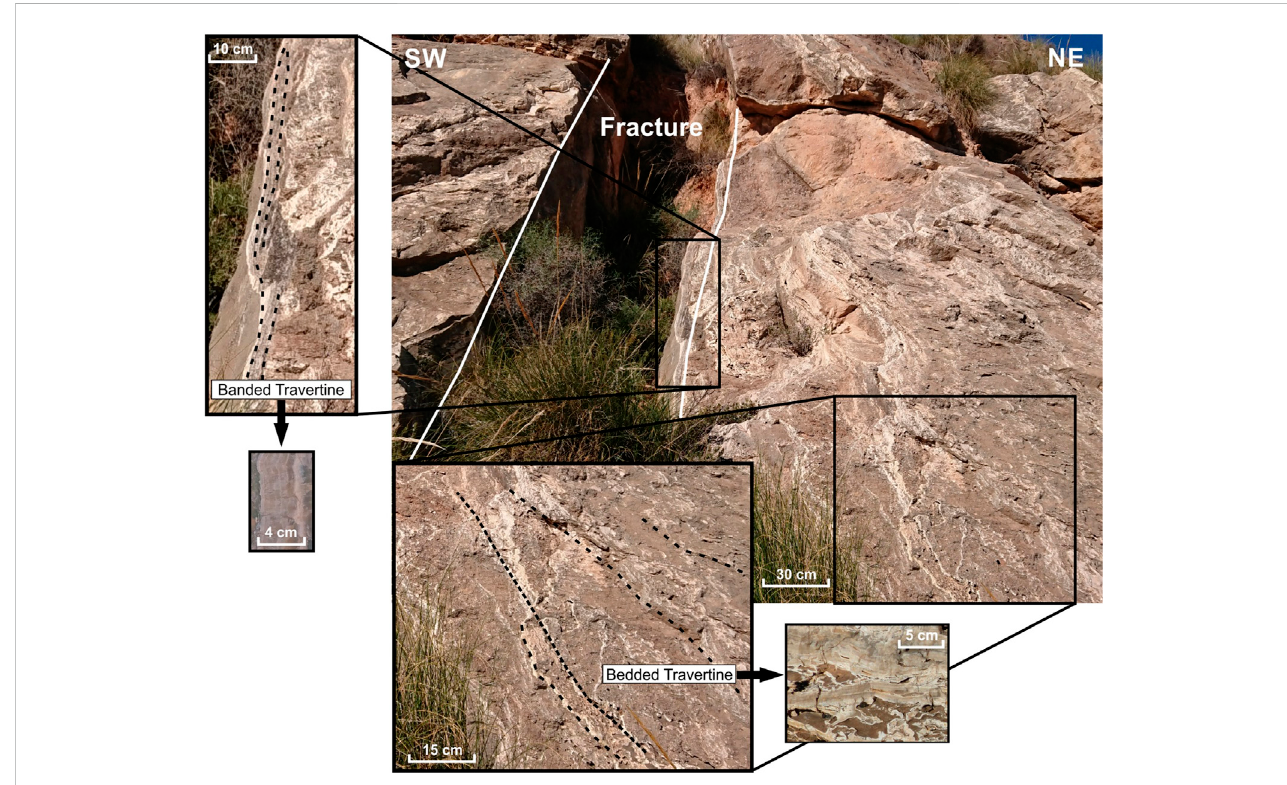
FIGURE 6 Field images of the bedded and banded travertine relationship. Banded travertine are the result of travertine precipitation fi lling faults or fractures, and bedded travertine are developed on slopes. In this case, both types of travertine have a crystalline crust lithotype (see the detail images).